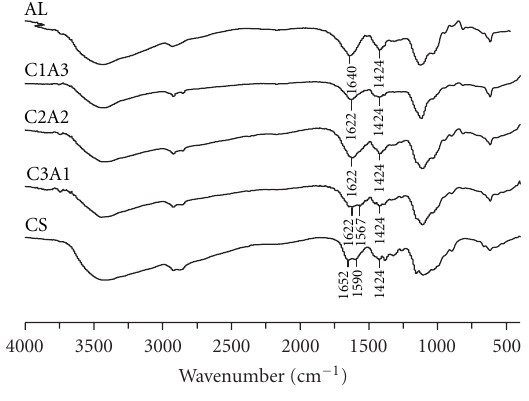
Figure 2: FTIR spectra of various sponges. Table 1: Water uptake ability of chitosan-alginate